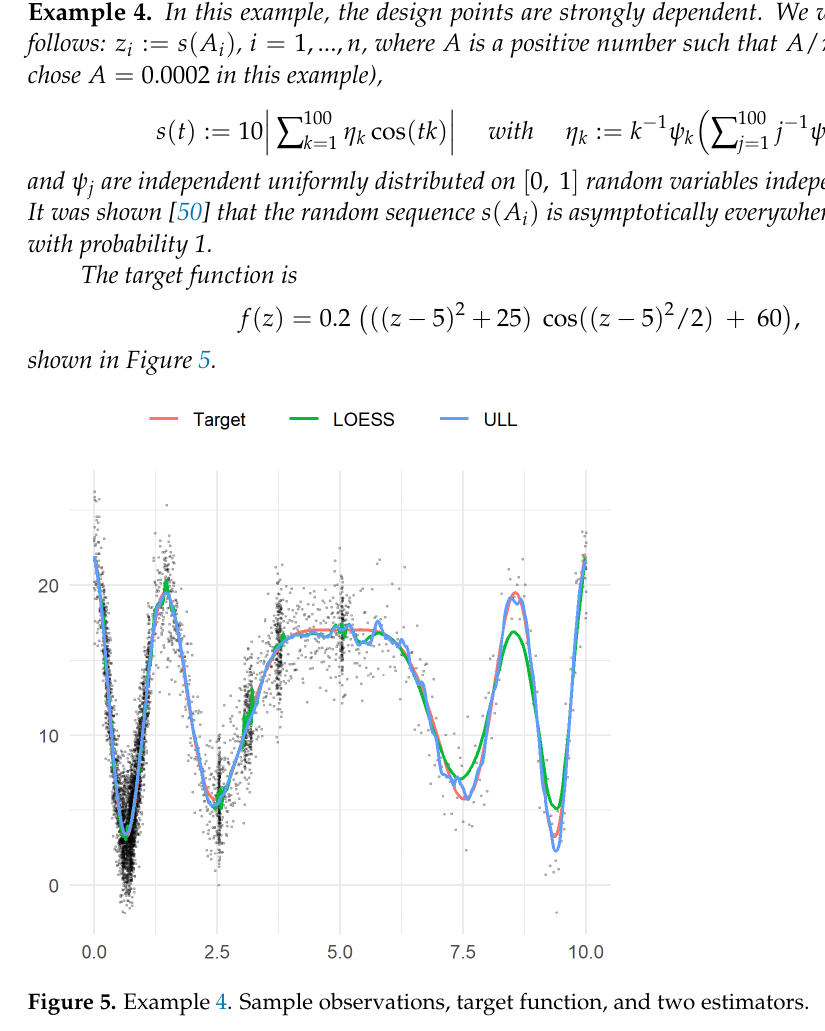
Figure 4. The maximum ( left ) and mean squared ( right ) errors in Example 3. For the mean-squared error, the random forest model performed worse (6.699 (6.412, 7.046)) than the GAM model and the kernel estimators, so the results of the random forest model “did not fit” into the plot.